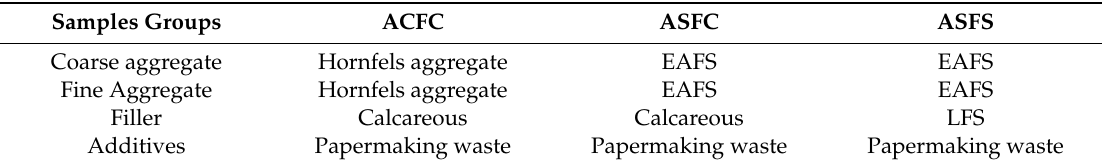
Table 2. Families of bituminous mixtures conformed with electric arc furnace slag, Hornfels aggregate, ladle furnace slag, calcareous filler and fibers from the papermaking